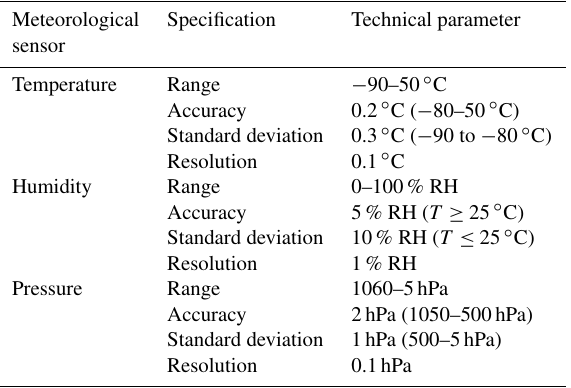
Table 3. Component parameters of the GTS1